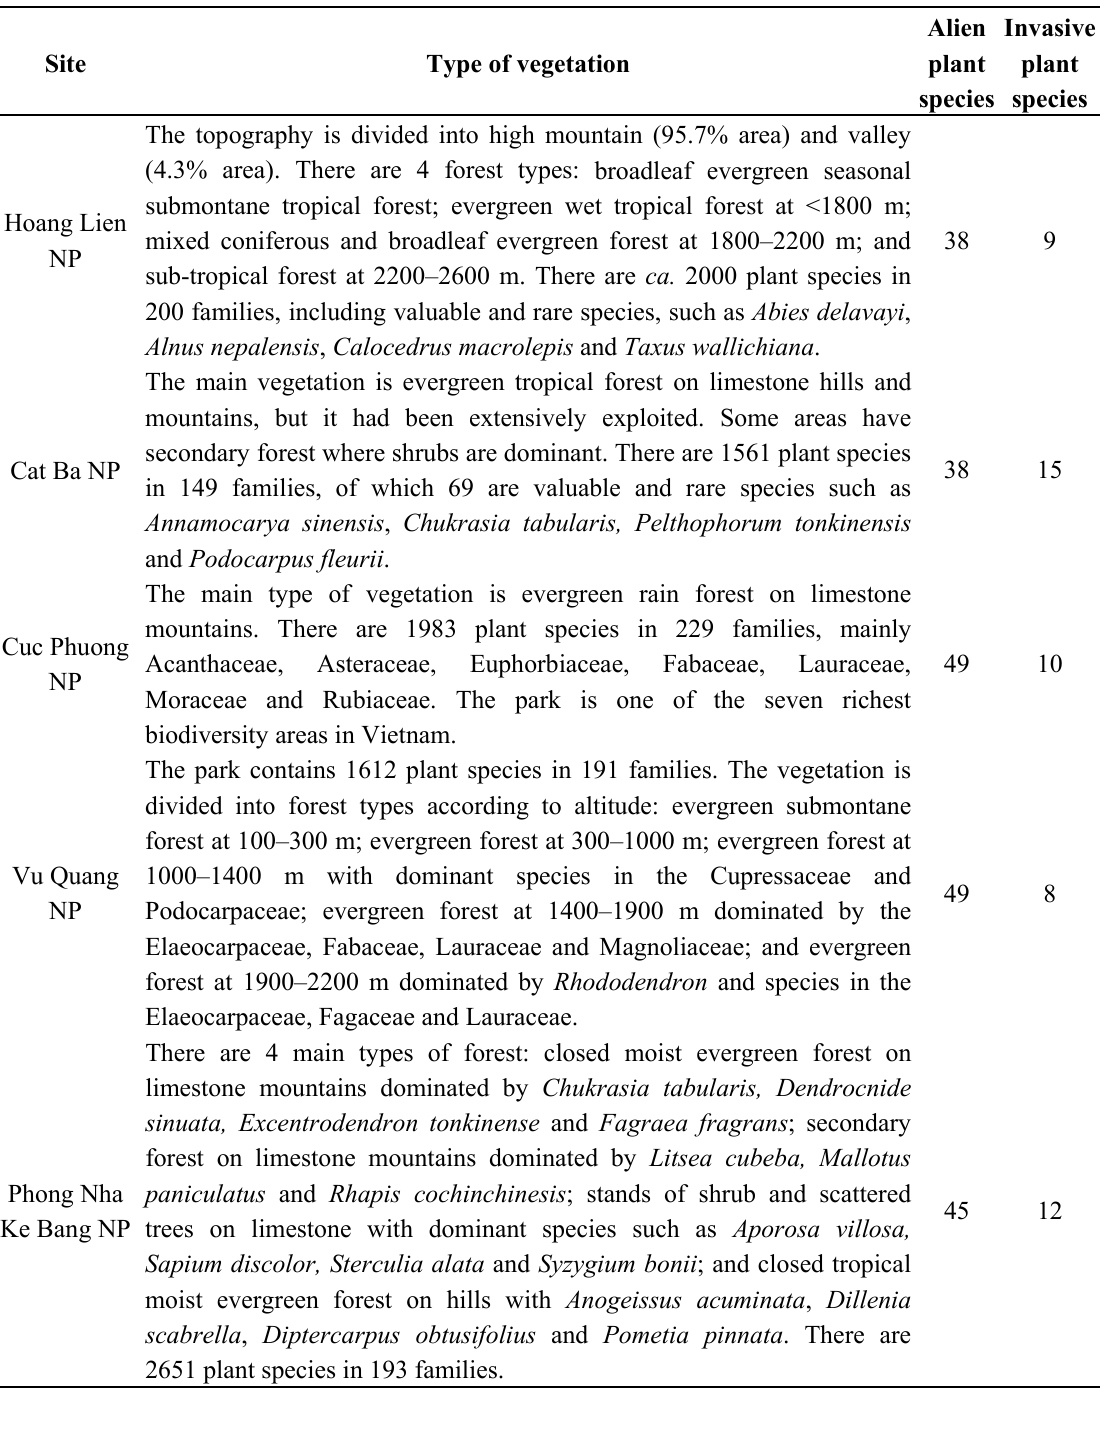
Table 1. Description of vegetation and the number of alien and invasive plant species for the 10 parks surveyed in